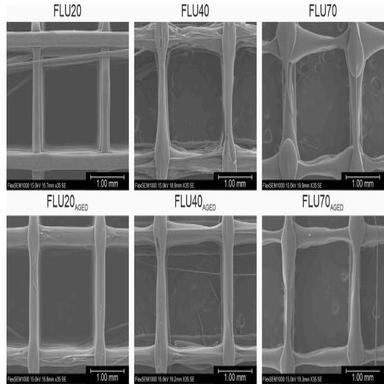
Scanning electron microscopy images of 3D printed tablets (top views, magnification 35×).